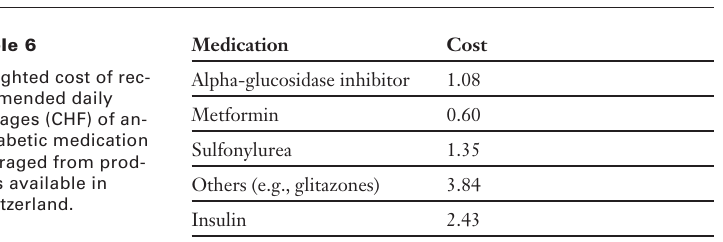
Cost (CHF) of SMBG items.